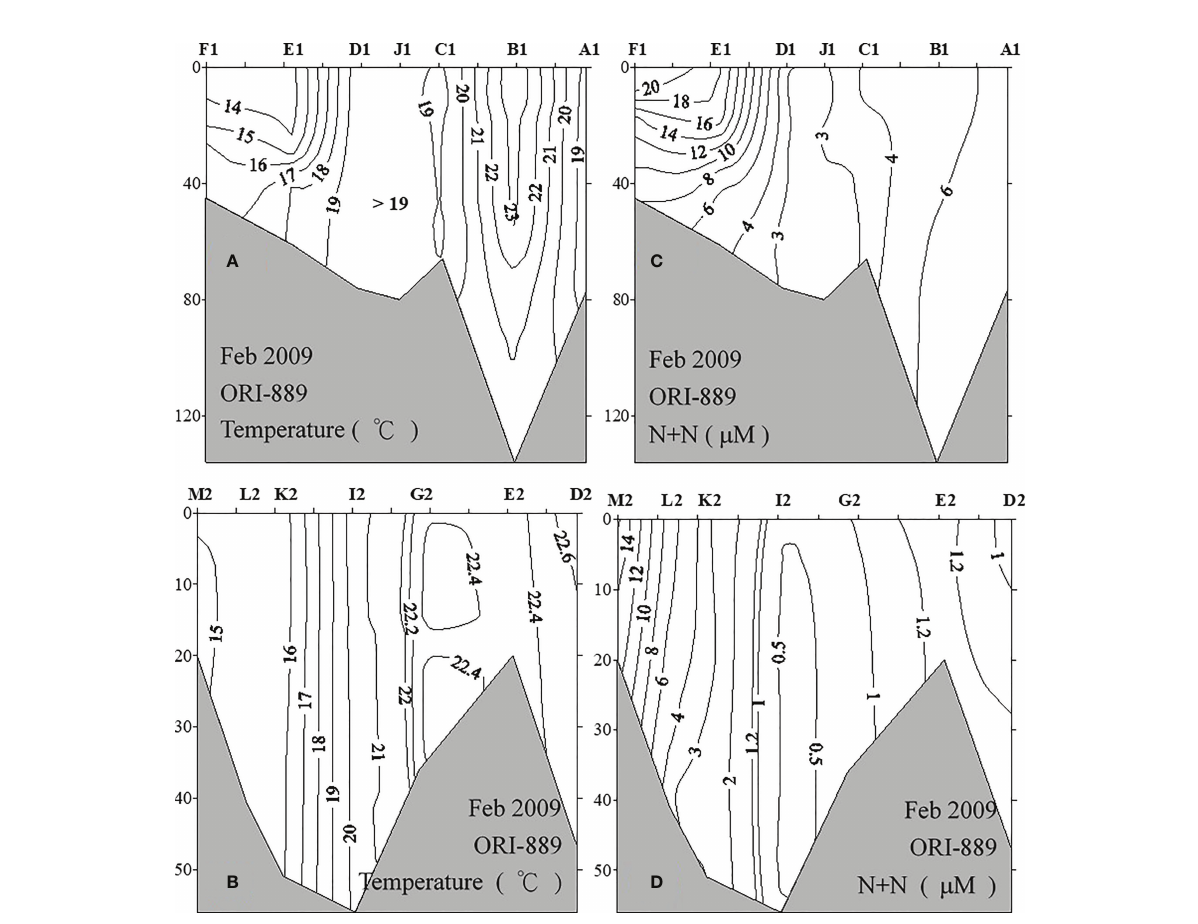
FIGURE 10 Temperature and N+N contours in the pro fi les of water samples from along the northern ( A , C ; upper panel) and southern ( B , D ; lower panel) TS-crossing transects in winter (Feb.